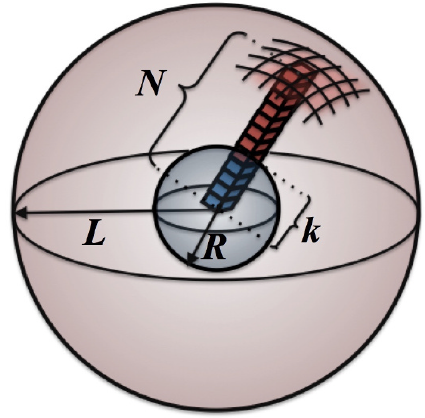
Figure 5 . The degrees of freedom on the holographic screen at radius L consist of single ‘long strings’. The degrees of freedom on holographic screens at radius R 0 = k‘ with k < N consist of ‘fractional strings’. The total number of long (or fractional) strings is proportional to the area of the holographic screen at radius L (or R 0